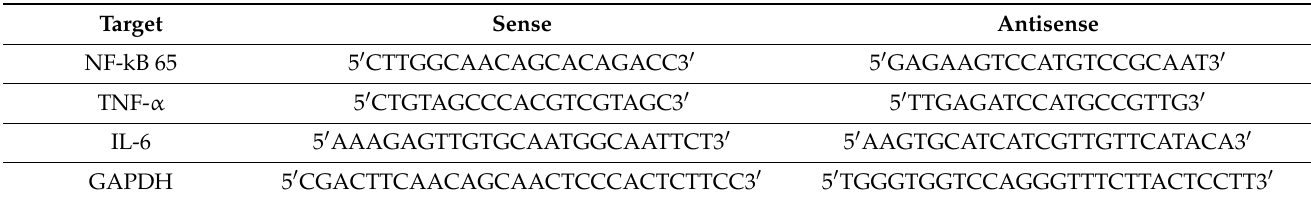
Table 1. Primer sequences for